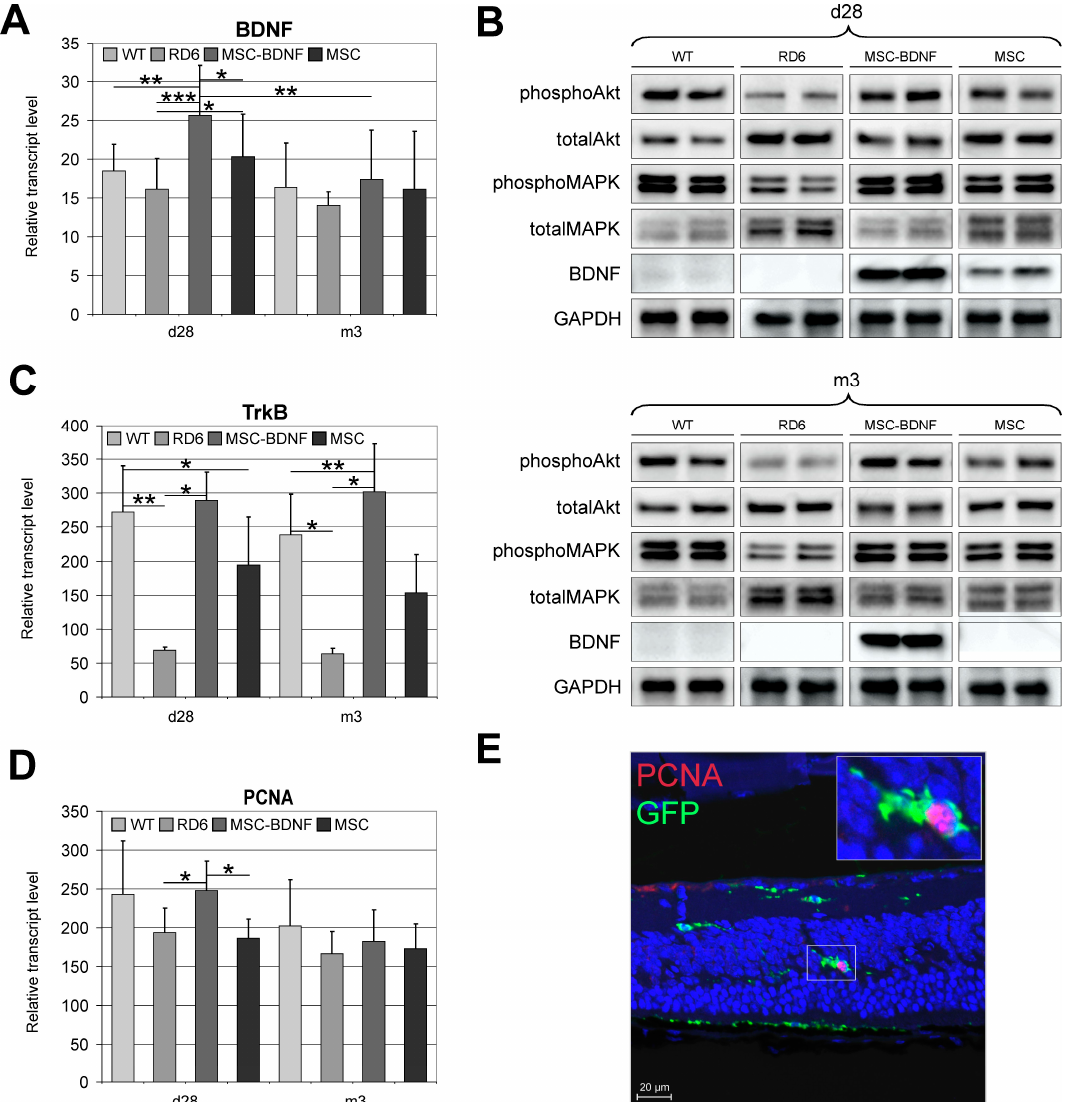
Figure 3. Long-term follow-up of BDNF production and its biological function at different time points post-intravitreal MSC-BDNF transplantation. BDNF mRNA ( A ), BDNF, phosphoAkt, totalAkt, phosphoMAPK and totalMAPK protein ( B ) expression was detected in retinas from eyes treated with MSC-BDNF, and their levels were significantly increased post-transplantation compared to other groups: at 28 days in case of mRNA and protein and at three months in the case of BDNF protein only. We also observed increased TrkB gene expression in retinas at 28 days and three months after MSC-BDNF and MSC alone transplantation compared to rd6 and wild type (WT) ( C ). The follow-up of retinal cell proliferation at different time points post-intravitreal transplantation in rd6 mice was also performed. Quantitative analysis of proliferating cell nuclear antigen (PCNA) mRNA expression revealed that their levels were significantly increased in retinas from eyes treated with MSC-BDNF